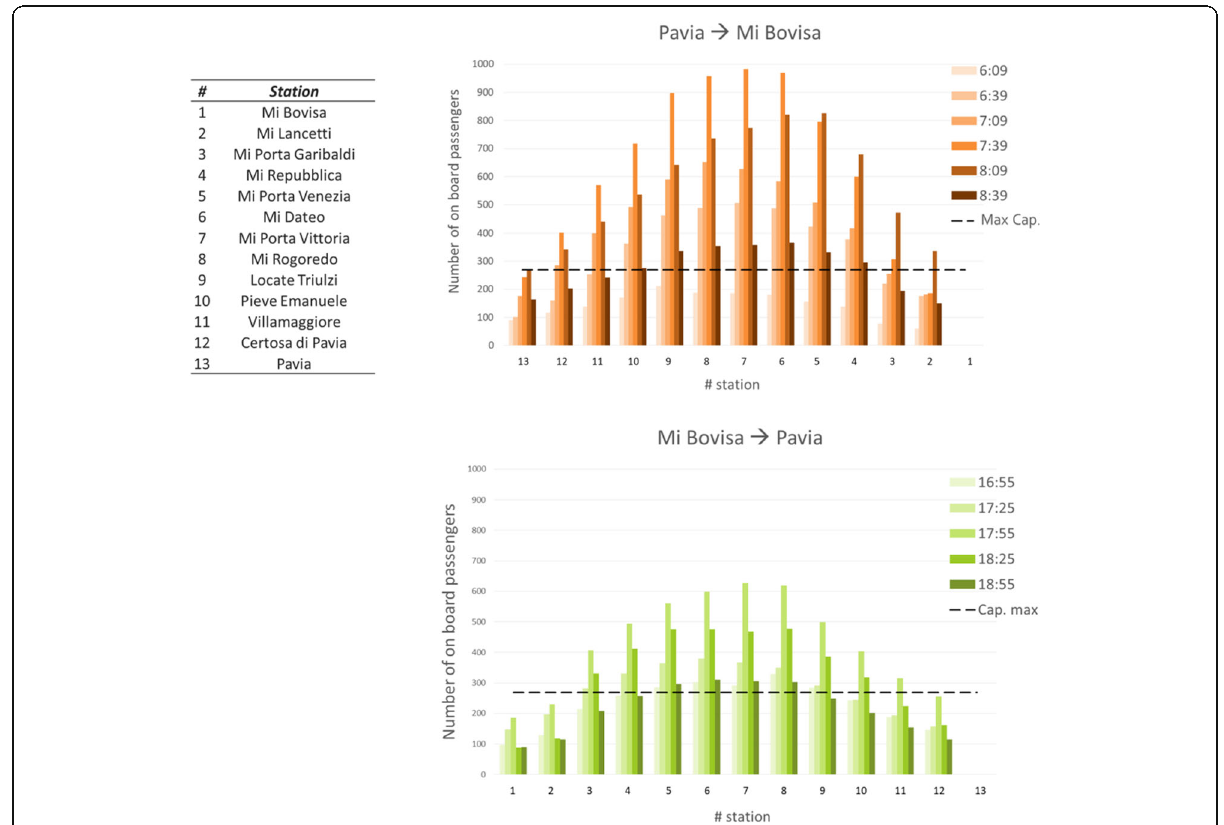
Fig. 6 Flow diagram of passengers on-board S13 line train during the morning peak in the Pavia – Bovisa direction and in the evening peak in the Bovisa-Pavia direction (Pre-COVID